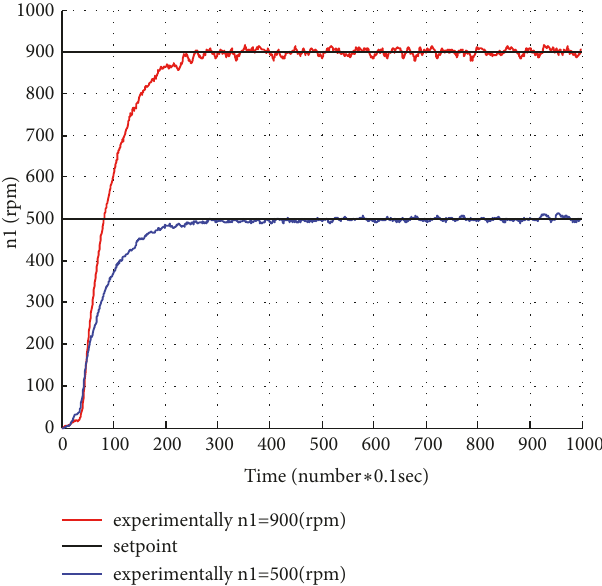
Figure 18: Velocity response of the working shaft at oil temperature of 70 ∘ C.